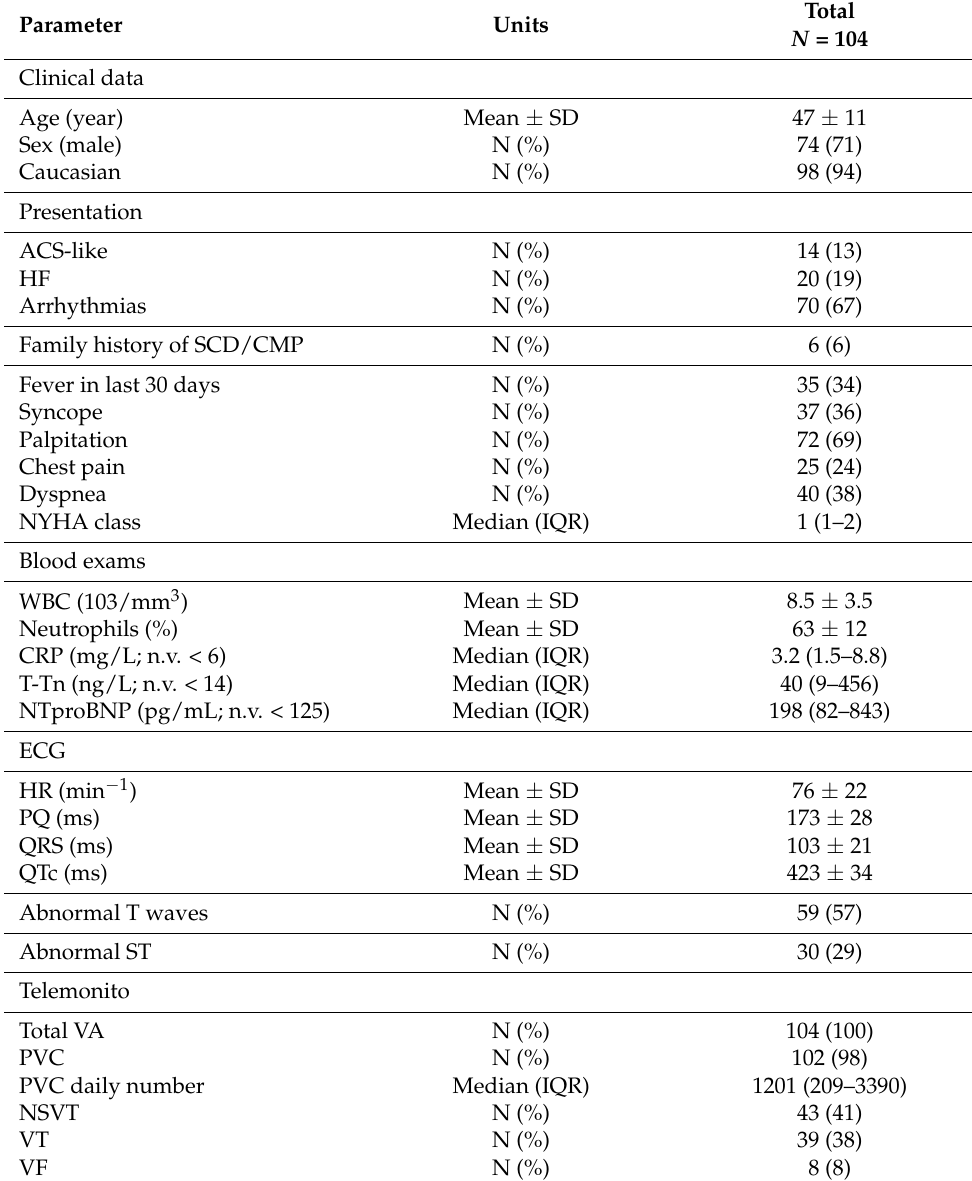
Table 1. Baseline characteristics of the